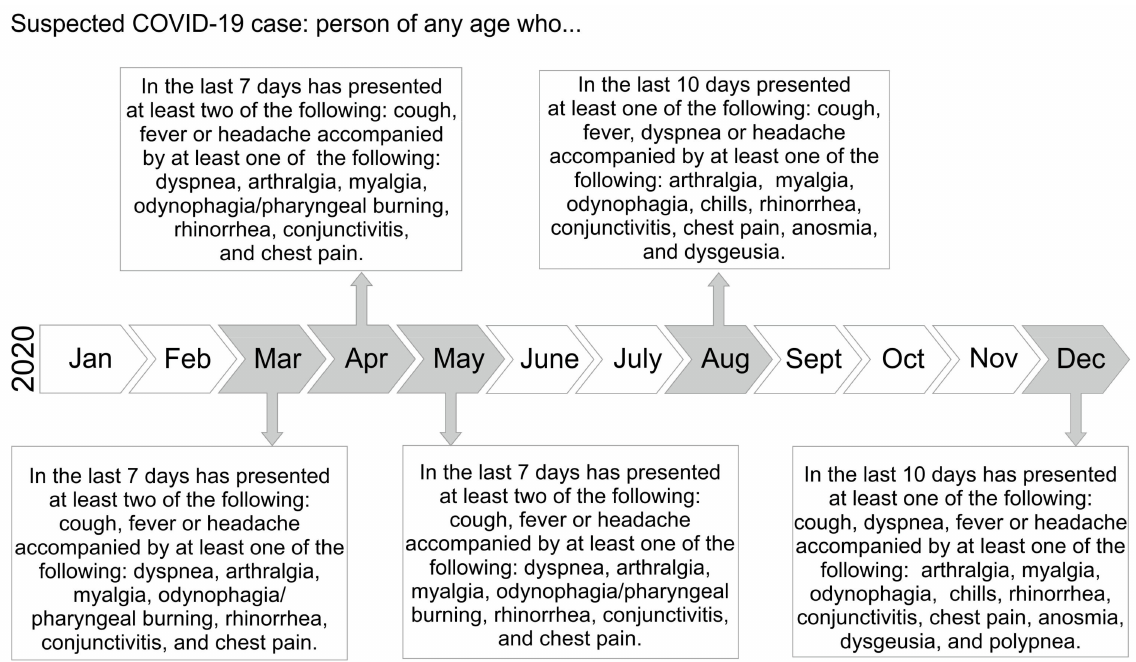
Figure 1. Evolution of the official Mexican operational definition of COVID-19 suspicious case. The Mexican government has updated the official operational definition of a suspected COVID-19 case five times throughout 2020. The operational definition from March to May 2020 included: a person of any age who had filed in the previous 7 days at least two of the following signs and symptoms: cough, fever, or headache, accompanied by at least one of the following signs and symptoms: dyspnea, arthralgia, myalgia, odynophagia, rhinorrhea, conjunctivitis, and chest pain. In August, the update was based on increasing to 10 the days in which the symptoms could occur, in addition, it decreased to one symptom presented in 10 days, and the symptoms were divided into major (cough, fever, dyspnea, or headache) and minor (myalgia, arthralgia, odynophagia, chills, chest pain, rhinorrhea, anosmia, dysgeusia, conjunctivitis). The last update was in December 2020 and included polypnea as a minor symptom